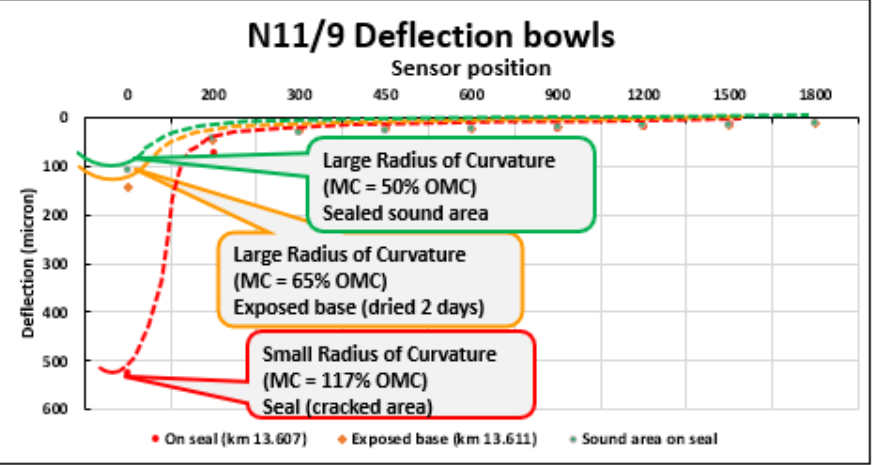
Figure 5. Influence of moisture content on base top softening and measured in terms of Radius of Curvature (RoC).